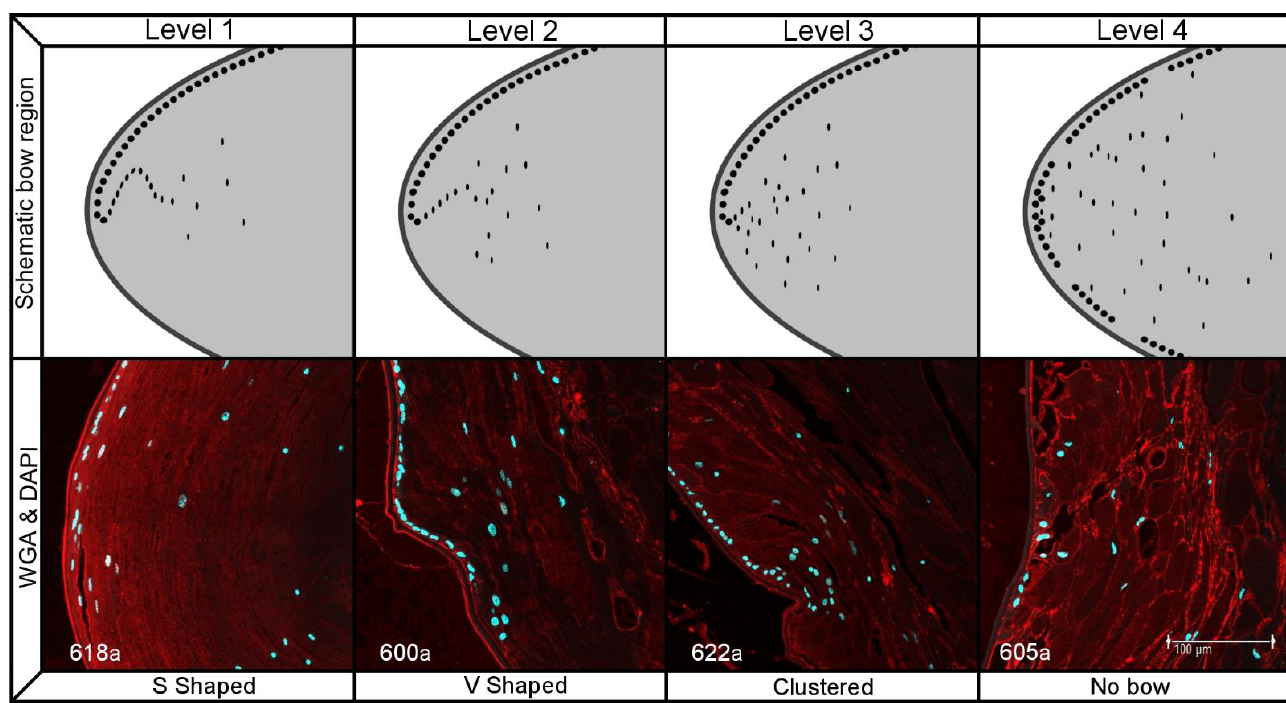
Figure 3. Schematic and histological representation of the 4 levels of nuclei organization at the bow. Scale bar = 100 µm .